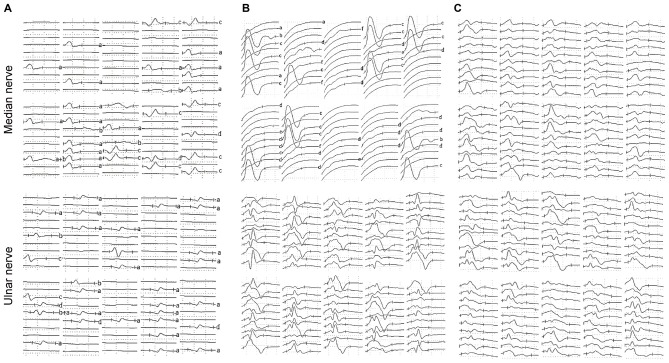
Representative examples of F-waves recorded from the amyotrophic lateral sclerosis (ALS) patients and the normal controls (NCs). (A) F-waves recorded from an ALS patient hand exhibiting wasting and weakness. Reduced F-wave persistence and increased number of repeater F-waves were observed on F-waves recorded from both the median and ulnar nerves. (B) F-waves recorded from an ALS patient hand lacking detectable wasting or weakness. The F-wave persistence was reduced and the number of repeater F-waves was increased on the median nerve, while parameters of F-waves recorded from the ulnar nerve were relatively normal. (C) F-waves recorded from a healthy subject on the left upper limb. F-wave amplitudes, latencies and waveforms were variable, and F-wave persistence was normal on both the median and ulnar nerves. Letters to the right of record identify repeater F-waves on the basis of amplitude, latency and waveform. Calibrations are 0.5 mV and 5 ms for F-wave recording.